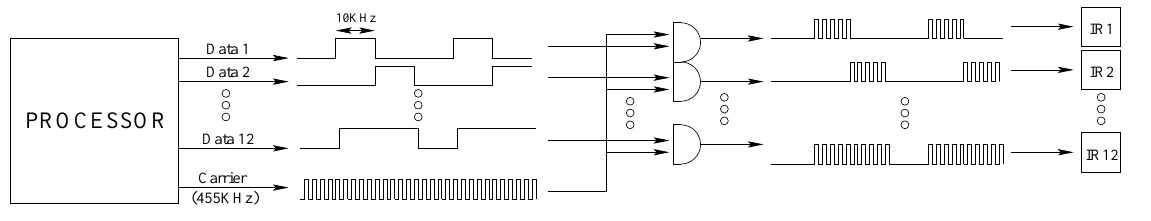
Figure 6. Emission module diagram.